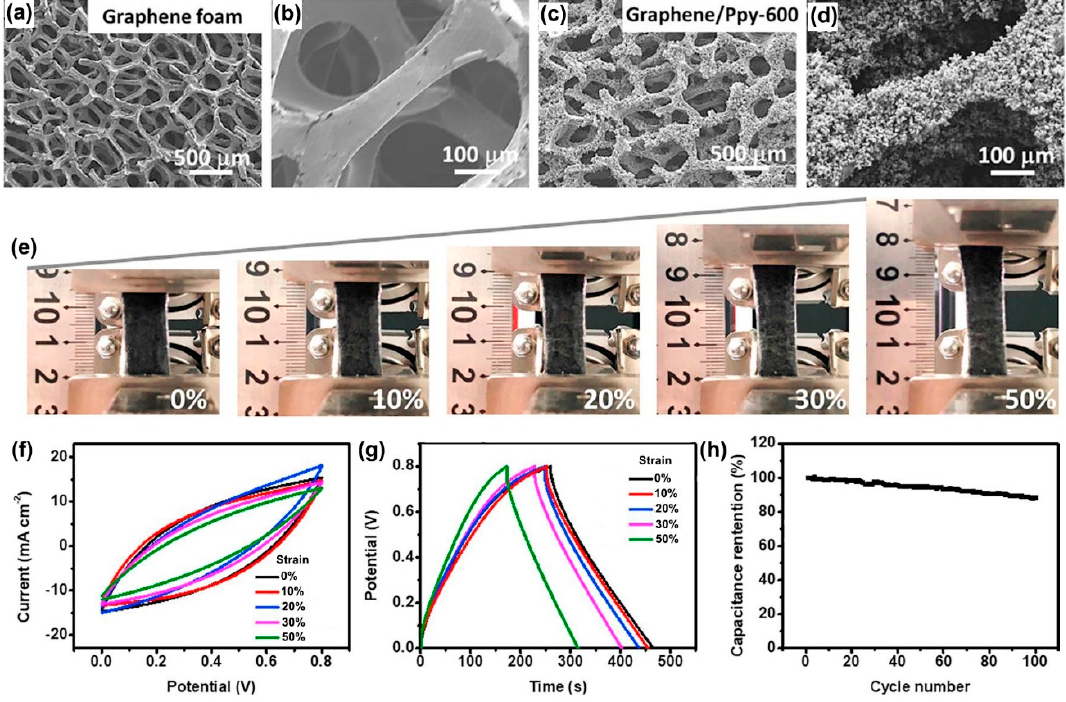
Figure 14. SEM images of ( a , b ) graphene foam; ( c , d ) graphene/PPy-600 at different magnifications; ( e ) digital photographs of a graphene/PPy-600 all-solid-state supercapacitor being stretched from 0% to 50% strain; ( f ) CV curves of the supercapacitor under different tensile strain; ( g ) GCD curves of the supercapacitor under different tensile strains; ( h ) dependence of the normalized capacitance on the number of stretching cycles for a tensile strain of 30%. Reproduced with permission from [136].